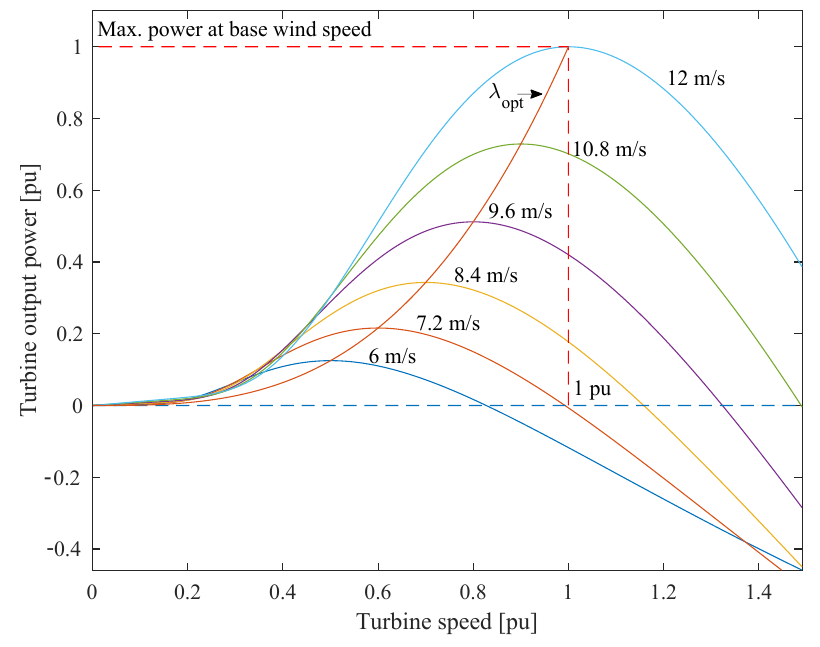
Figure 2. Turbine power characteristics with β =